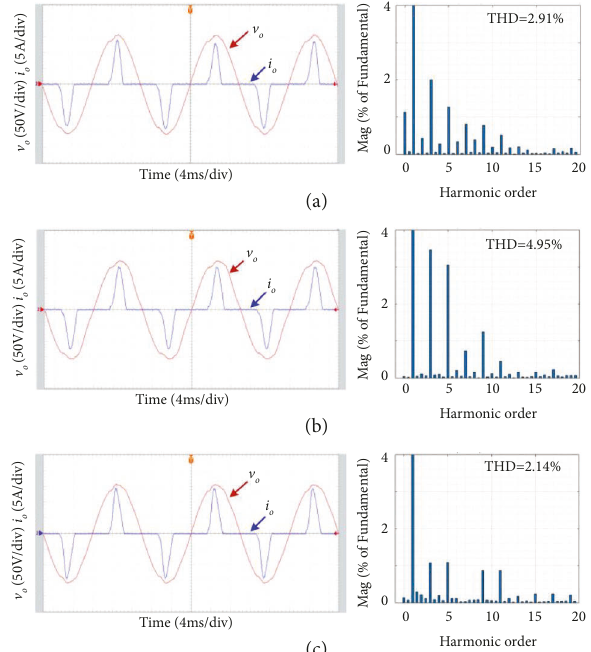
Figure 20: Steady-state waveforms of different control strategies under highly nonlinear load conditions. (a) SRFPI, (b) LADRC, and (c) proposed SRFPI-LADRC.